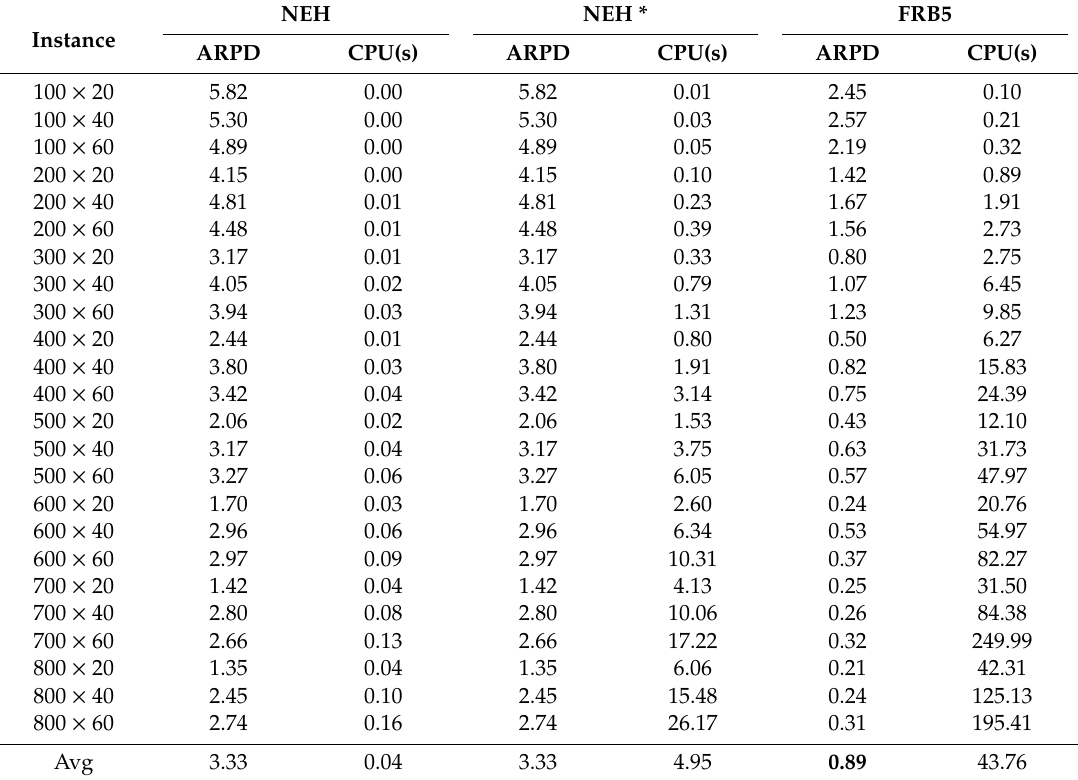
Table 5. Comparison of ARPD and computation time (CPU) for constructive heuristic methods (The number in bold shows better